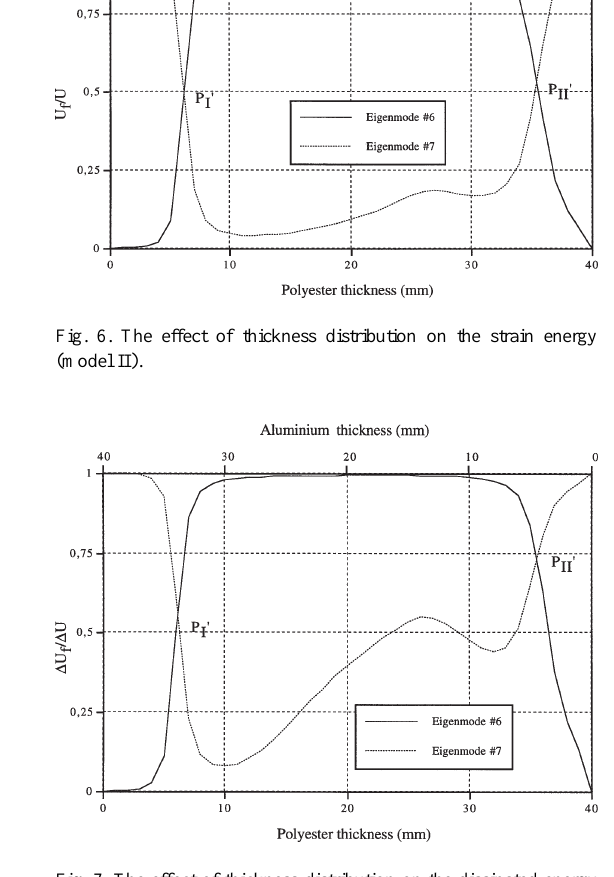
Fig. 7. The effect of thickness distribution on the dissipated energy (model